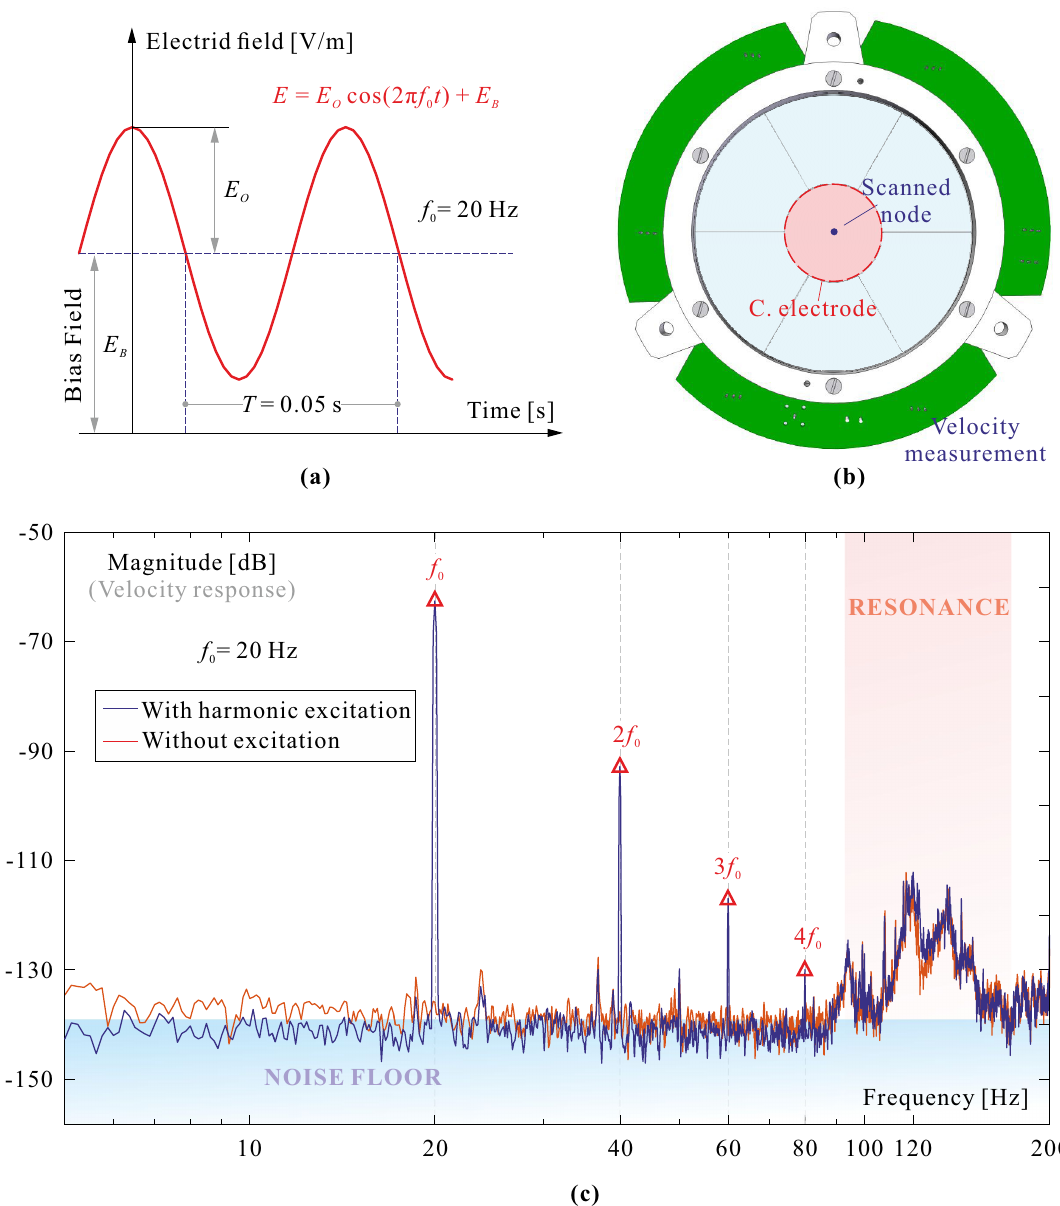
Figure 7. ( a ) Harmonic excitation with bias E B , amplitude E 0 and frequency ω 0 = 2 π f 0 . ( b ) test structure: spherical shell of 100 mm diameter with 7 electrodes. The excitation is applied to the central electrode and the laser vibrometer measures the velocity at the center of the mirror. ( c ) Fourier analysis of the velocity